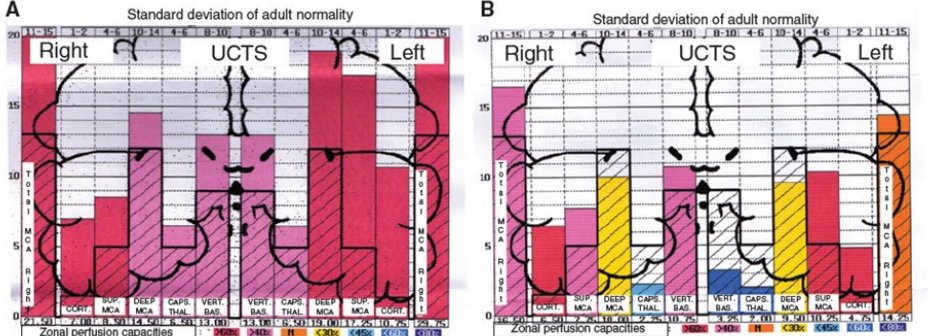
Figure 3. Examples of diagrams obtained from the database by using ultrasonic cerebral tomosphygmography (UCTS), exploring the global centimetric ultrasound tissue pulsatility in the two temporal lobes of a normal subject ( A ) and of an EHS self-reported patient ( B ), according to References [11,12]. Measurements are expressed as pulsometric index (PI). Note that, in A and B, mean values of PI in each explored area are recorded from the cortex to the internal part of each temporal lobe (i.e., from left to right for the right lobe, and from right to left for the left lobe). In addition, note that, in A (normal subject), all values are over the median normal PI values, whereas, in B (EHS self-reported patient), values in the so called capsulo-thalamic areas (the fifth and the second column for the right and left temporal lobes, respectively) are significantly under the median normal values, suggesting that the limbic system and the thalamus in each temporal lobe may be involved in EHS, as exemplified in this